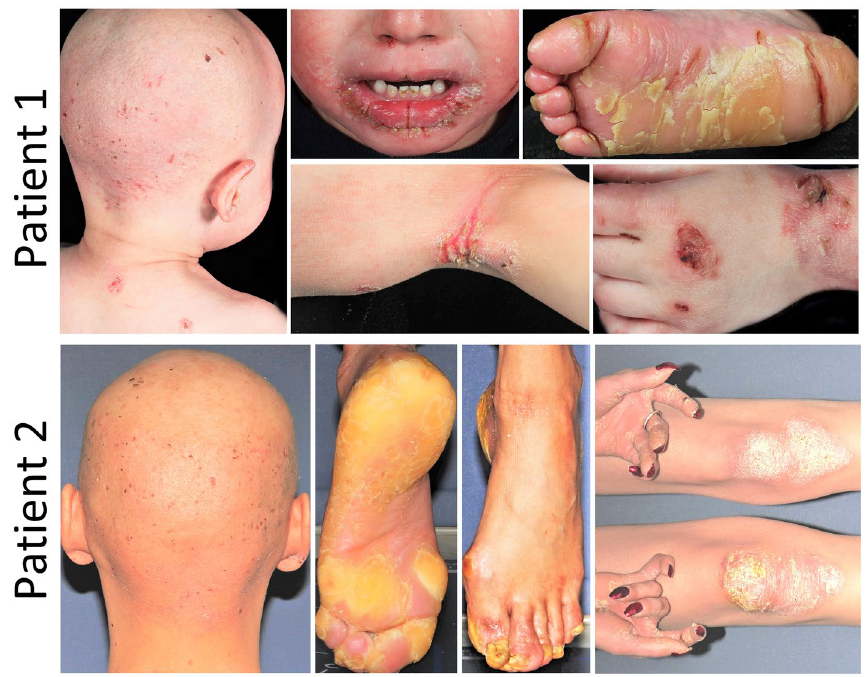
Figure 1. Clinical findings in patients with JUP-associated spectrum of skin fragility. Patient 1 (upper panel): A 2.5-year-old male manifested with trauma-induced blisters and erosions of the skin; perioral, axillary, plantar, and antecubital fissures; plantar hyperkeratosis; and absence of hair on his scalp. Patient 2 (lower panel): A 22-year-old female showed trauma-induced blisters and erosions; hyperkeratosis of palms, soles, knees and elbows; joint contractures of fingers; and absence of hair on her